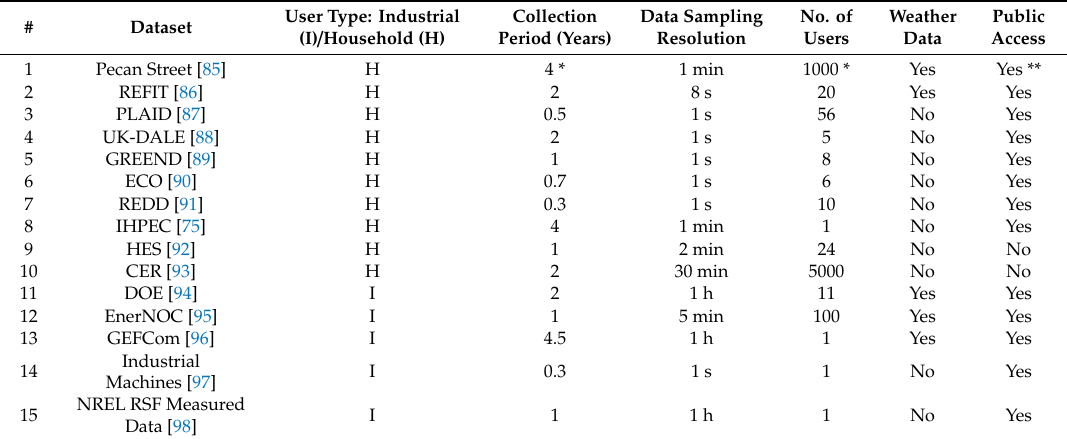
Table A1. Related datasets.